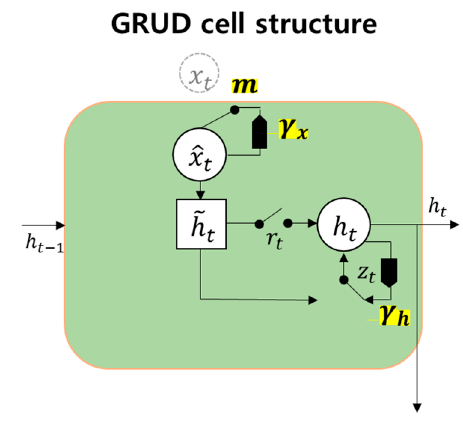
Figure 6. GRU-decay (GRUD) scheme assuming the current input is missing.